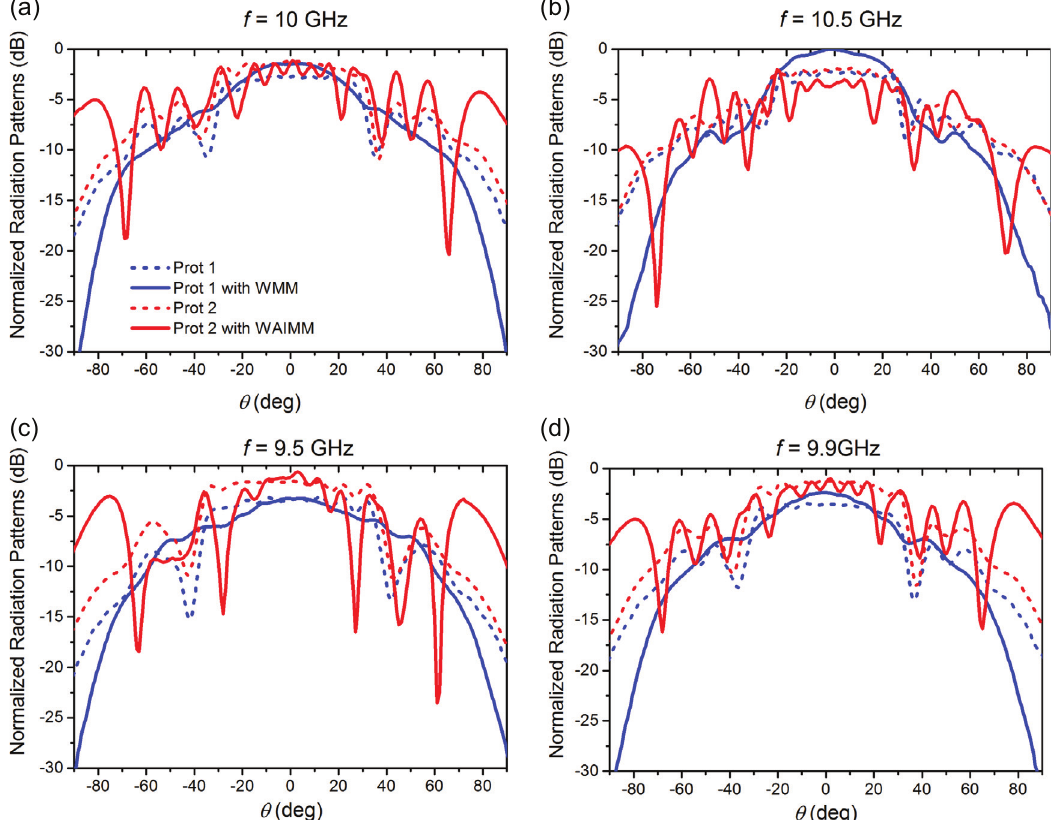
Figure 10. Experimental E-plane central element radiation pattern at different frequencies. Blue color line corresponds to the first prototype (wire medium solution) with (solid) and without (dashed) metaradome. Red color line corresponds to the first prototype (Jerusalem cross based solution) with (solid) and without (dashed) metaradome.